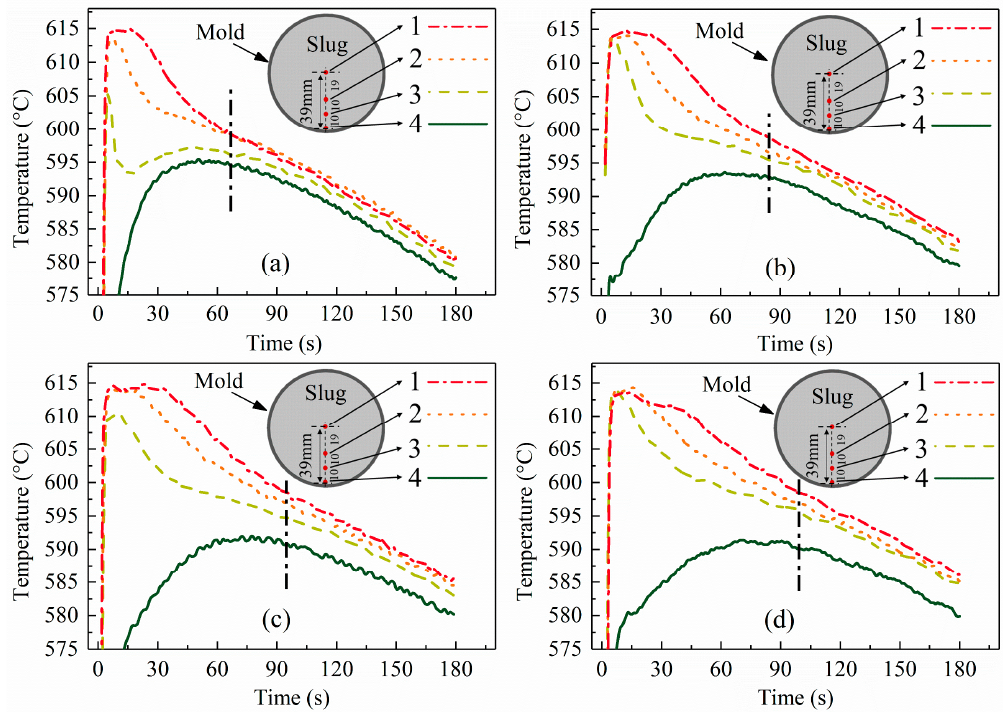
Figure 5. Temperature evolution of slug under different thicknesses of BN coating: ( a ) 0.0 mm, ( b ) 0.1 mm, ( c ) 0.5 mm, and ( d ) 1.0 mm. The black dashed lines mark the times at which the slug temperature distribution changed from unstable to quasi-stable.